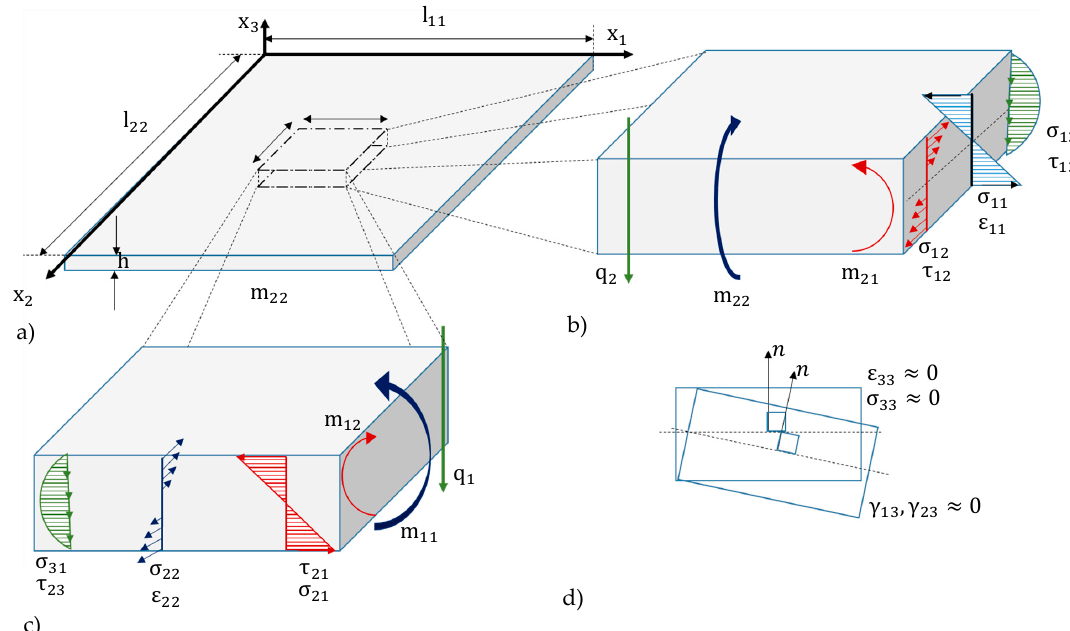
Figure 2. Rectangular thin plate with high bending stiffness ( a ); ( b , c ) Thickness-dependent stress and strain distributions and plate element with internal moments due to the stress distribution along the thickness h; ( d ) Undeflected and deflected plate element, (adapted from Reference [27]). To derive a simplified mechanical model from the plate theory, only small curvatures of the plate center surface, are considered (Figure 3). It follows: